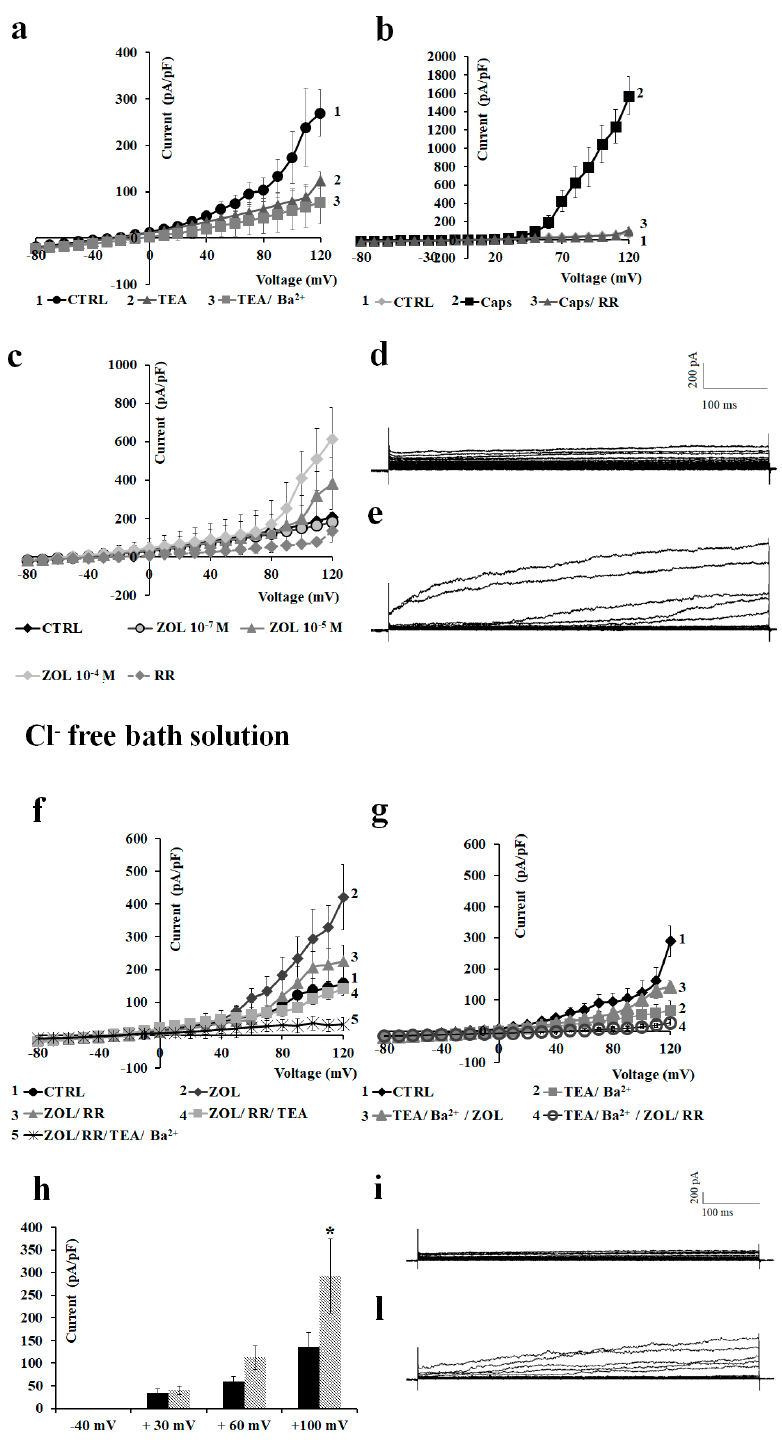
Figure 5. Electrophysiological characterization of macroscopic K + -currents and transient receptor potential (TRP) channel currents recorded in preosteoblast-like cells MC3T3-E1 in whole-cell configuration. The current was recorded using physiological K + concentration in the bath and pipette, and was obtained in response to voltage pulses from − 80 to +120 mV in 10 mV steps, starting from HP = − 60 mV. Each point represented the mean ± SEM of 5–7 patches. ( a ) Inhibitory response of control currents to TEA (5 × 10 − 3 M) and Ba 2+ (5 × 10 − 3 M) that partially reduced the currents. ( b ) Activating